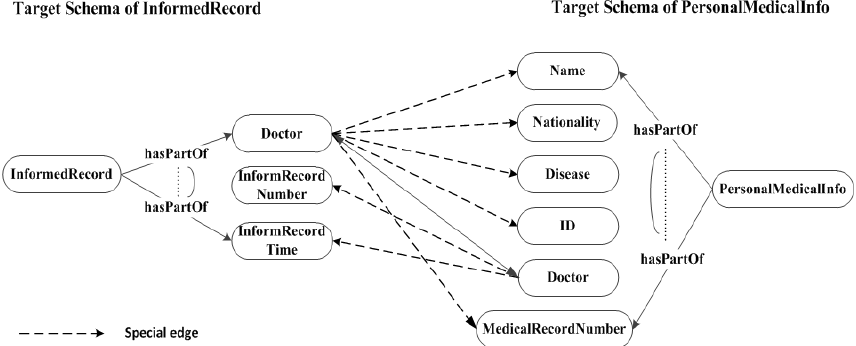
Figure 4. A target dependency the target schema of